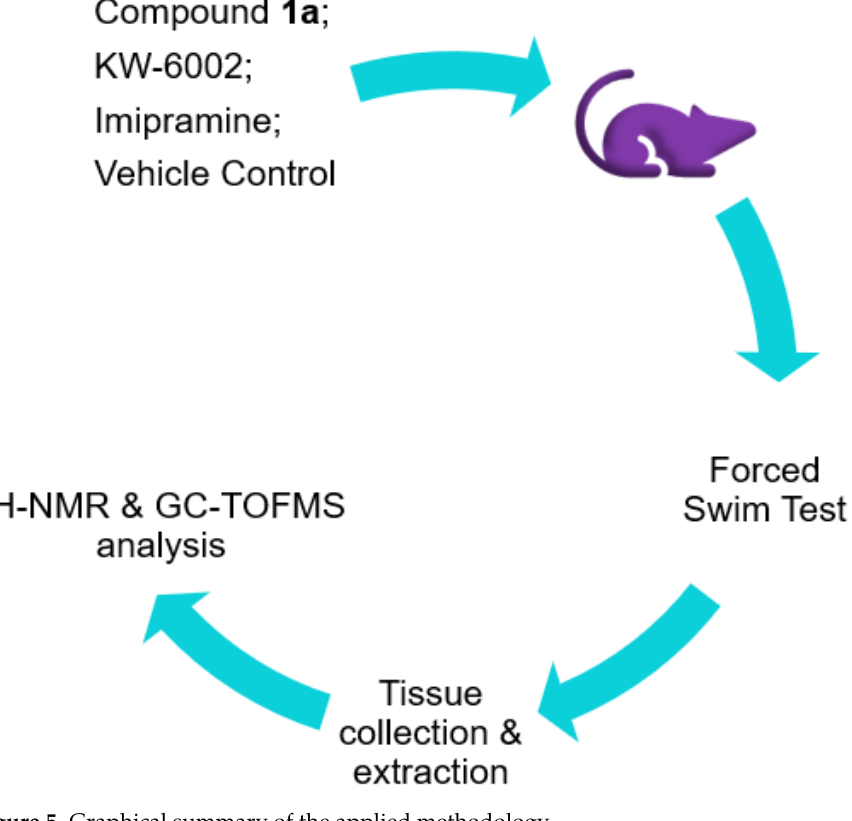
Figure 5. Graphical summary of the applied methodology.